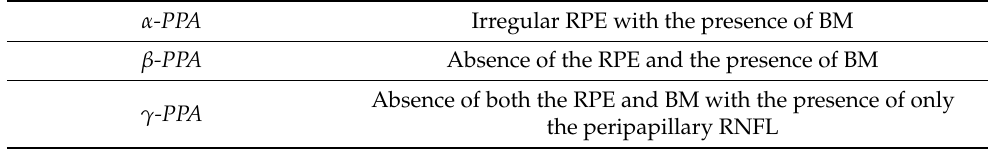
Table 1. ONH characteristics in myopic subjects. α -PPA Irregular RPE with the presence of BM β -PPA Absence of the RPE and the presence of BM Absence of both the RPE and BM with the presence of only γ -PPA the peripapillary